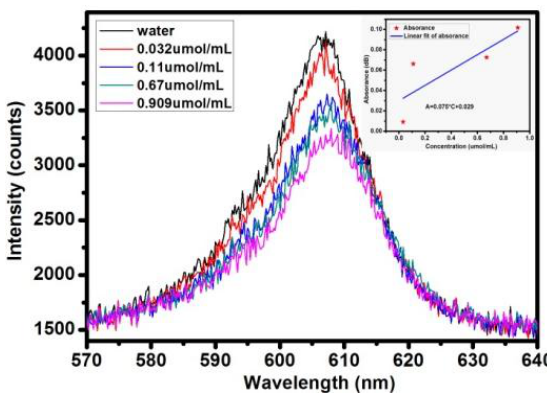
Figure 10. The test spectra of